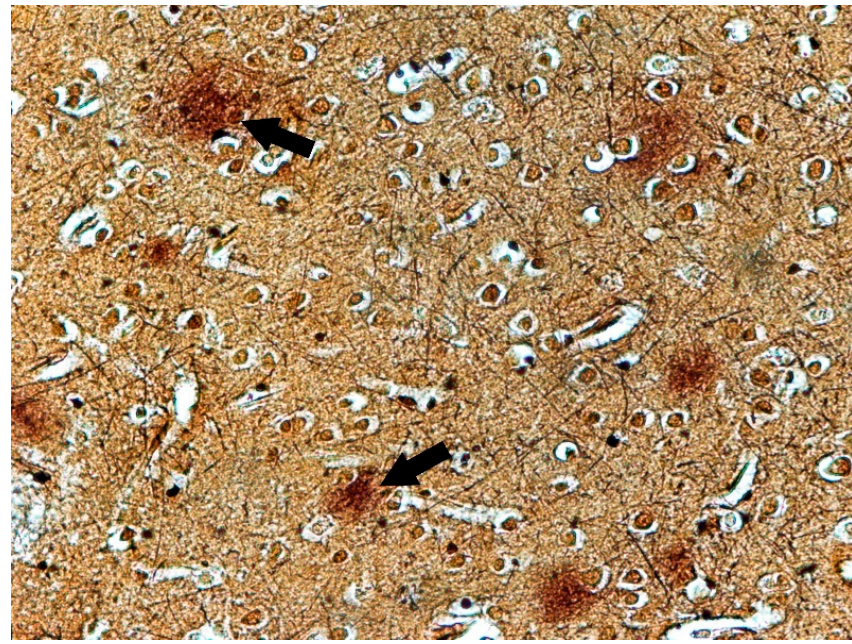
Figure 4. Case no. 1. Temporal lobe of the cortex. Visible senile plaques (arrows). Modified Bielschowsky’s stain, magnification 400×.